Question: Identify the chart type used in this figure.
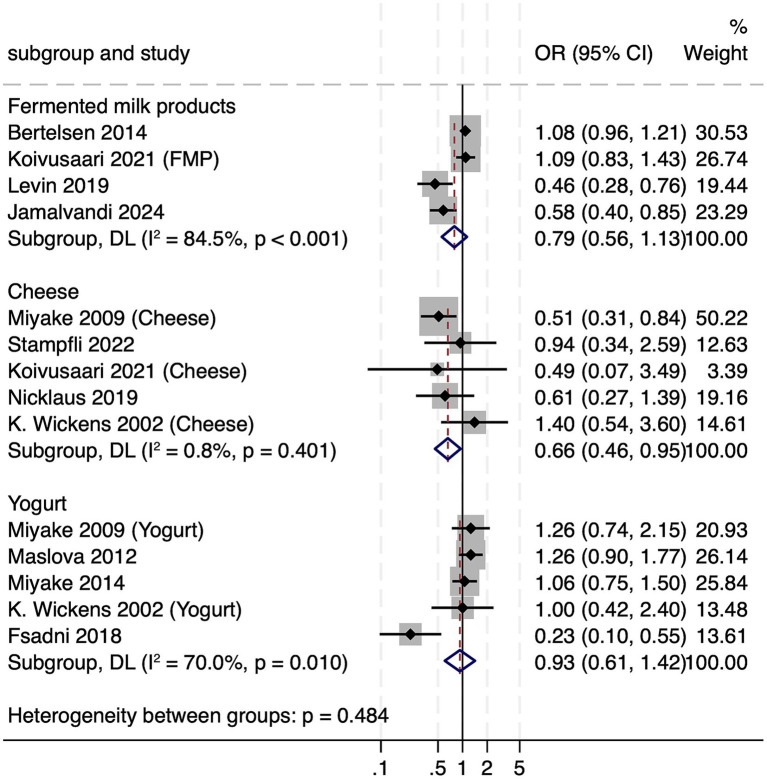
Answer: forest